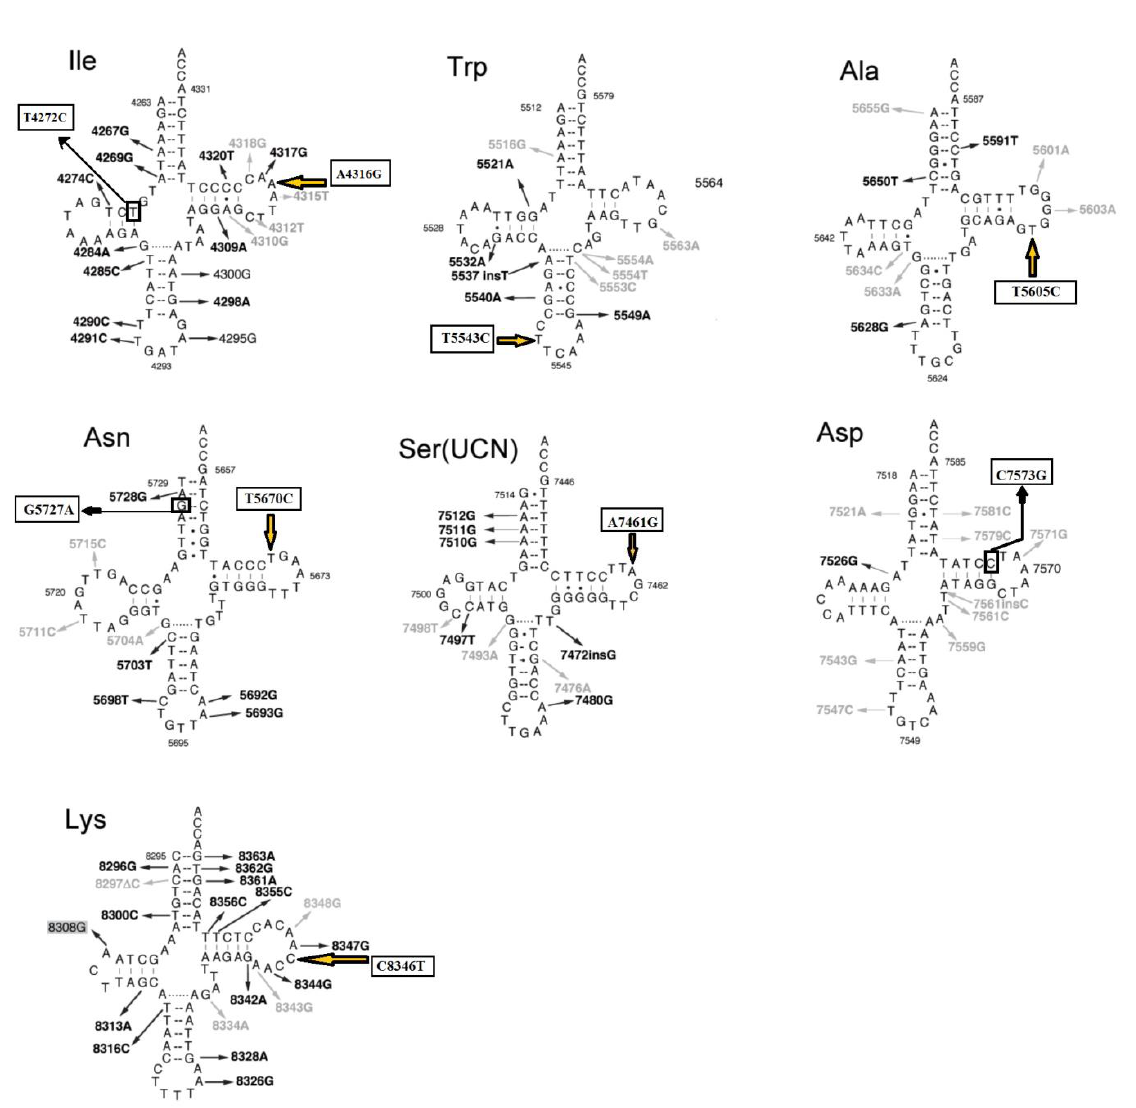
Figure 1: Position of nucleotide changes in the secondary structure of studied